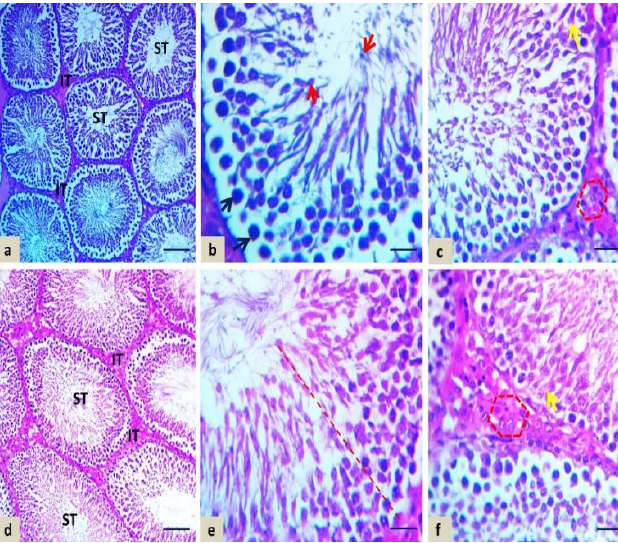
Figure 7. Microscopic photographs of seminiferous tubules sections of the right testis of diabetic male Wister rats treated with 500 mg/kg BW ( a-c ) and 1000 mg/kg BW ( d-f ) of Quercus infectoria galls (QIg) extract. a, Mild dilation of the seminiferous tubule (ST) and degenerated interstitial space (IT) (H&E, 200×); b, mild degenerated spermatid (red arrow) (H&E, 400×); c , mild degenerated Sertoli cells (yellow arrow) and Leydig cells (red polygonal) (H&E, 400×). d , Normal organized seminiferous tubule (ST) and interstitial space (IT) (H&E, 200×); e , Intact spermatogenic cells (red dash line) (H&E, 400×); f, intact Sertoli cells (yellow arrow) and Leydig cells (red polygonal) (H&E,